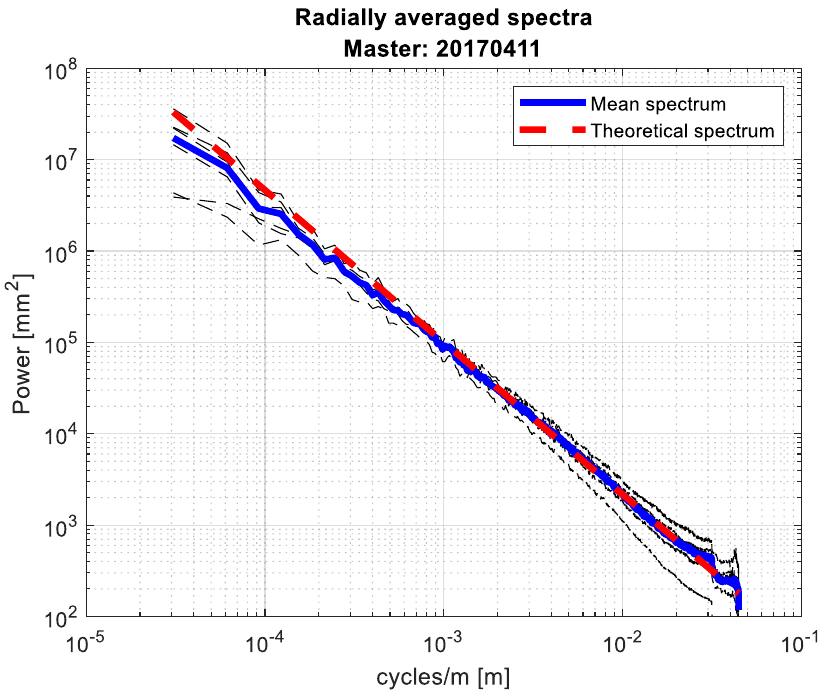
Figure 14. (black dashed lines) radially average power spectrum for all the APS maps derived using the dataset in Table 3. (blue line) mean of all the previous spectra. (red dashed line) theoretical spectrum computed with α = 5/3 .